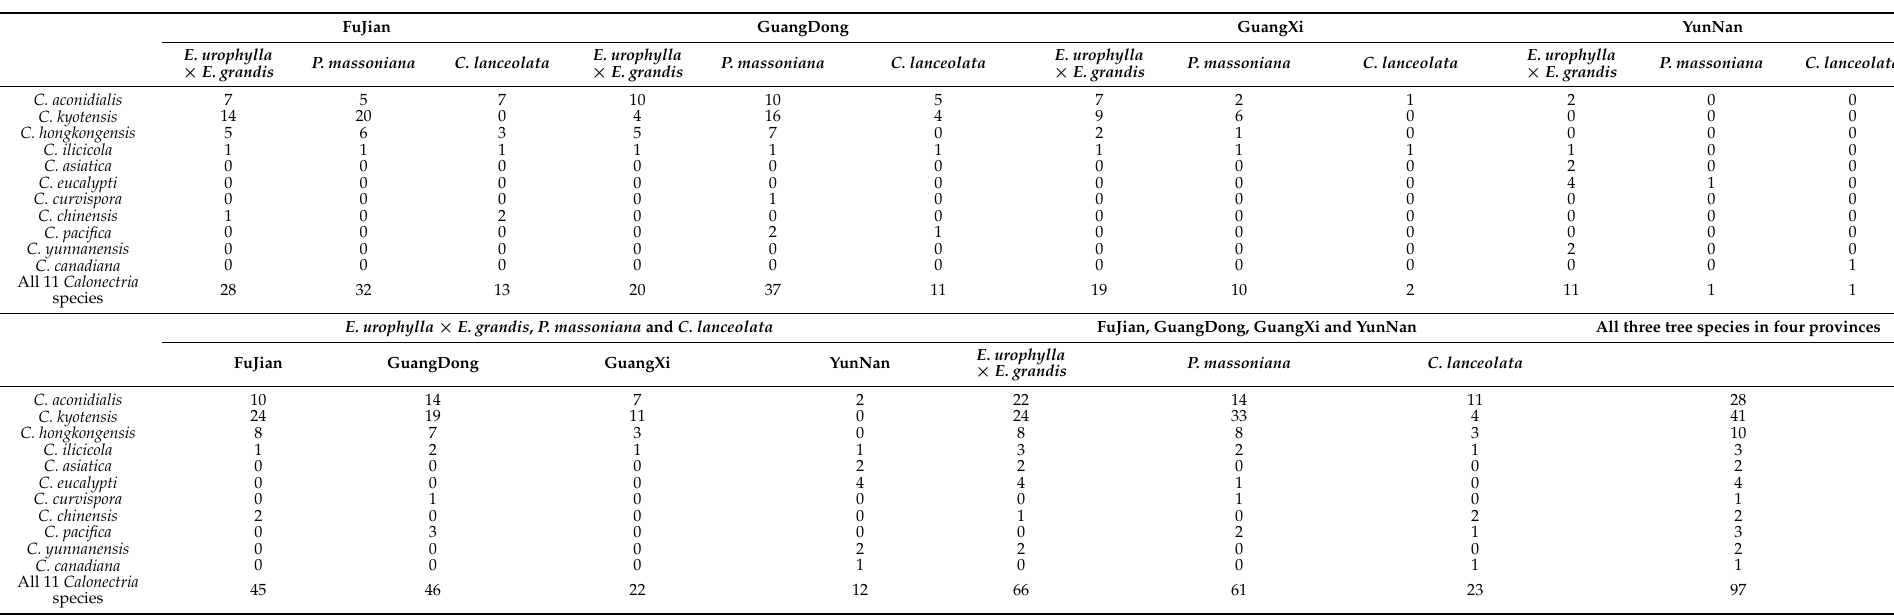
Table 7. Number of genotypes of each Calonectria species obtained from plantations of three tree species in four provinces, as determined by tef1 - tub2 gene sequences.